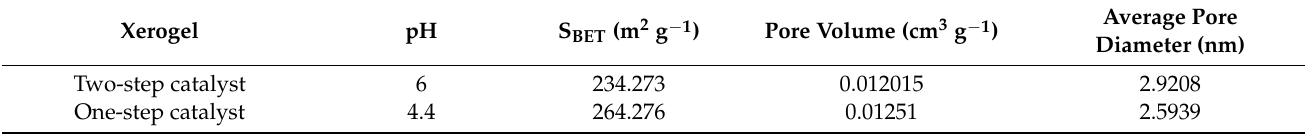
Table 3. Surface properties of the organo-silica xerogels.